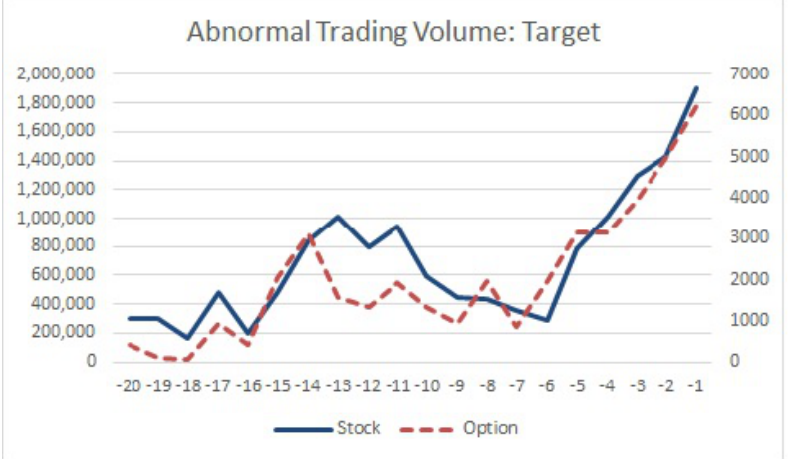
Figure 2. Stock and Option represent the average daily abnormal trading volume of targets’ stocks and options over the 20-day period prior to the announcement,